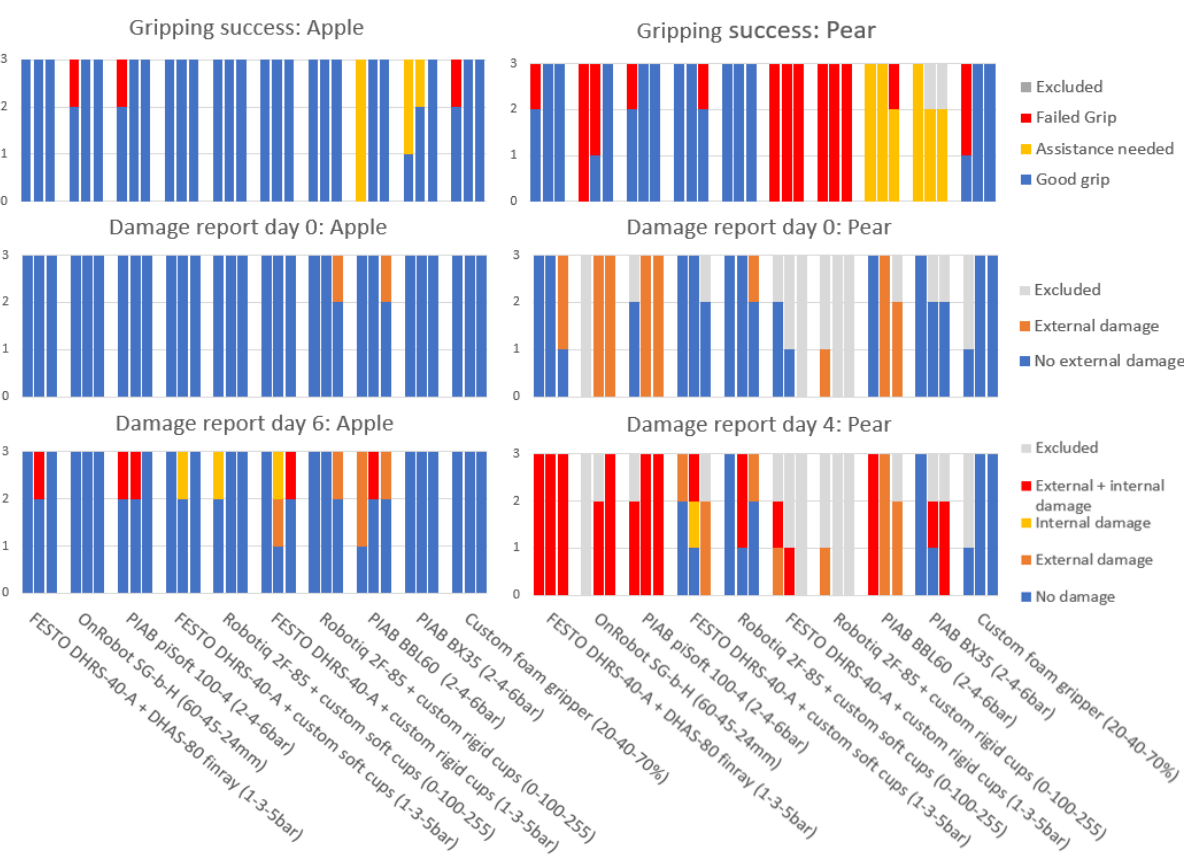
Figure 3. Synthesis of the test results: left are the results for apples, and right for pears. For each gripper tested, the three force settings, defined between brackets, are displayed in three separate columns.